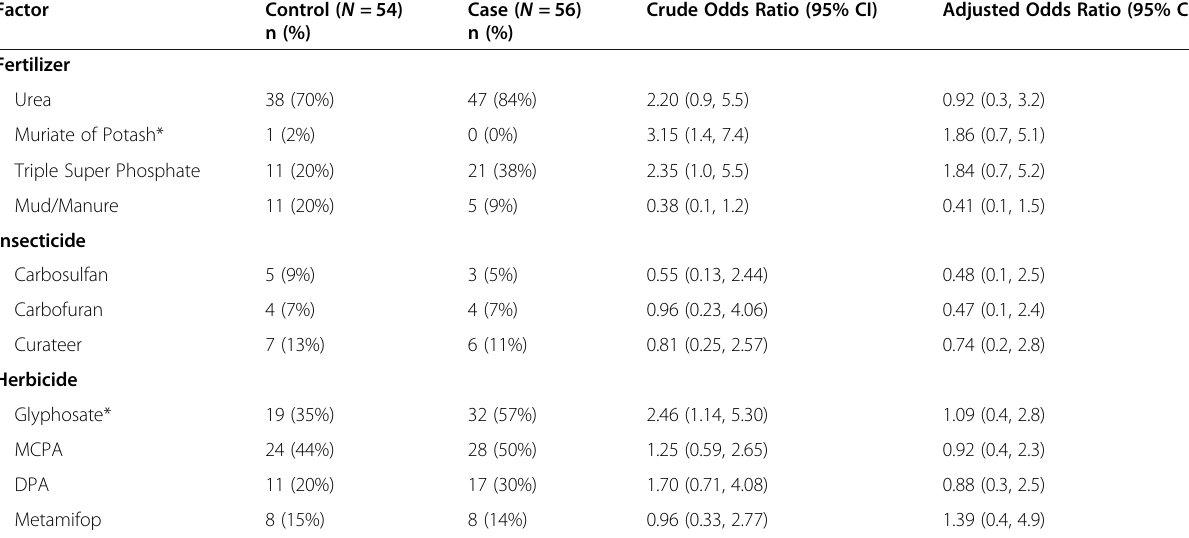
Table 4 Crude and Adjusted Odds Ratios for Agrochemical Association with CKDu Factor